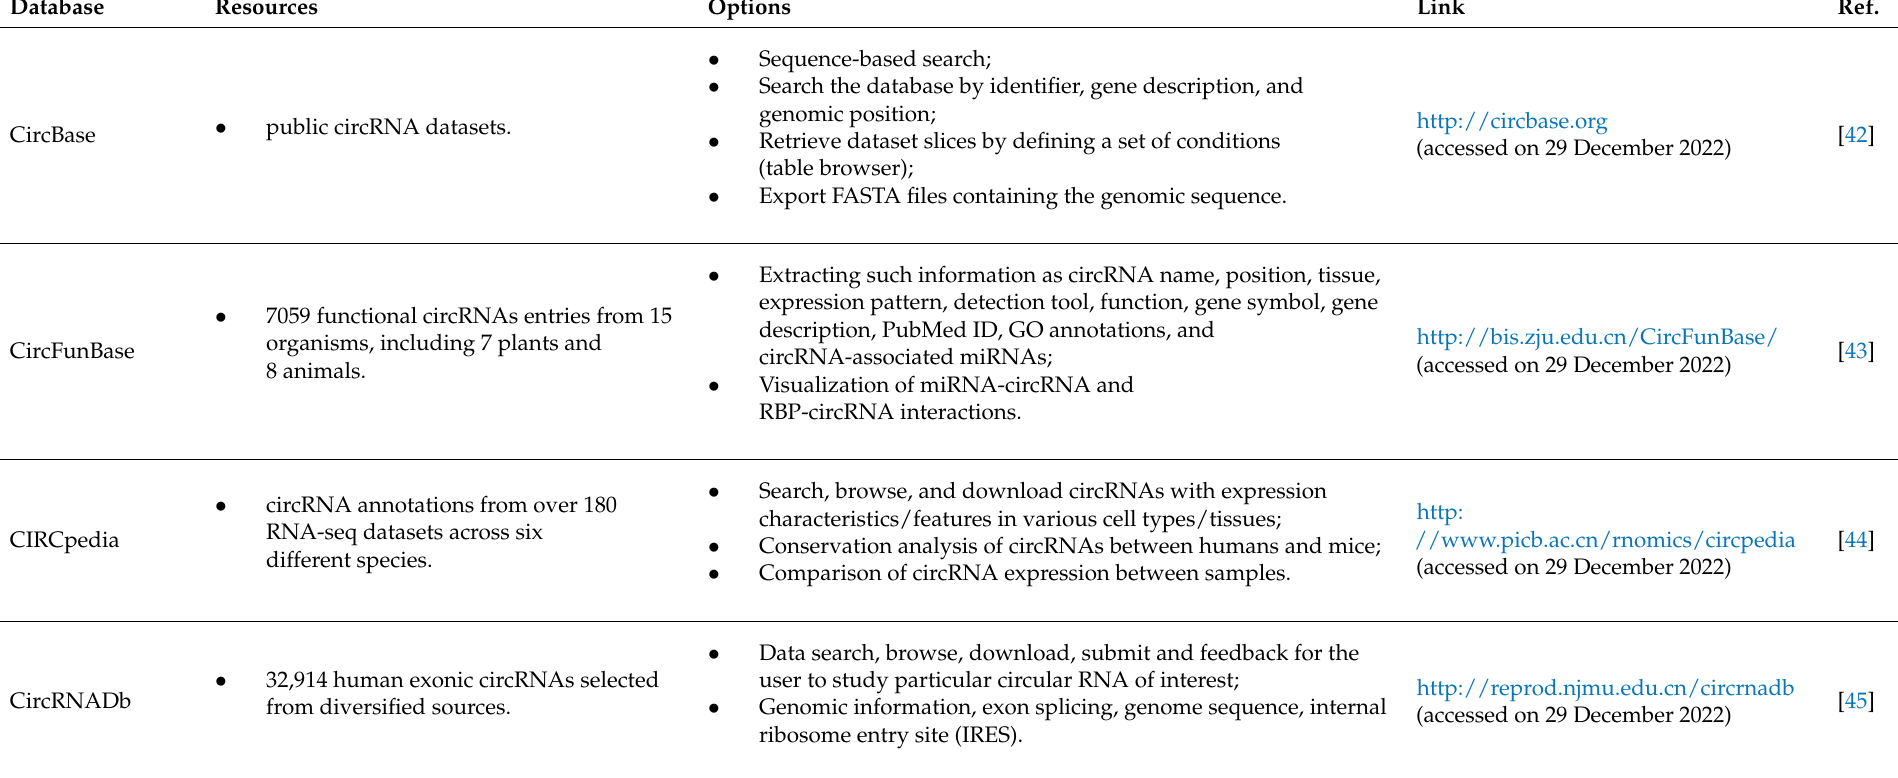
Table 1. Databases commonly used for the analysis of